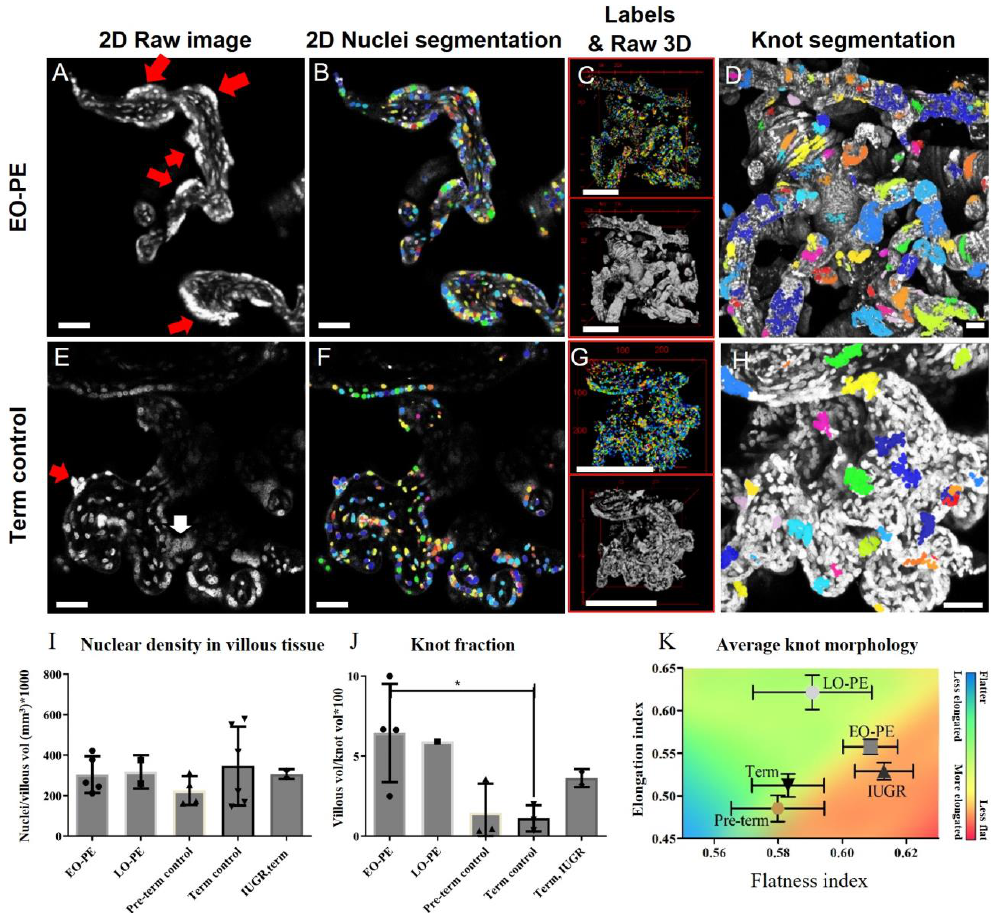
Figure 2. Nuclei segmentation with Stardist and knot segmentation with KnotMiner . ( A ) EO-PE, 2D section and ( B ) corresponding segmentation result. Red arrows point to syncytial knots. ( C ) A 3D raw image of nuclei and the corresponding 3D segmentation result. Larger images are available in Figure S5. ( D ) Segmentation of knots with KnotMiner , illustrated in the maximum intensity projec- tion of the image. ( E ) A 2D visualisation of nuclei in term control placenta. The white arrow points to a nuclear bridge (can be recognised by dense nuclei connecting two villi, but nuclei are not as bright as compared to knots). ( F ) Segmentation of nuclei in term control placenta. ( G ) The 3D seg- mentation results of nuclei in term control placenta. ( H ) Knot segmentation in term control placenta by KnotMiner . ( I ) Nuclear density (ratio of nuclei over villous volume). EO-PE n = 2 placentas (im- ages:5), LO-PE: n = 1 placenta, (images: 2), preterm: n = 2 (images 3), term control: n = 2 (images 3), IUGR: n = 1 (images:2). ( J ) Knot fraction (percentage of total knot volume over villous volume). ( K ) average knot morphology described by flatness and elongation index. Flatness index was not sig- nificantly different for the presented clinical cases. Samples in (J) and (K); EO-PE: n = 1 placenta (images:4), LO-PE: n = 1 (images: 1), preterm: n = 2 (images: 3), term control: n = 2 (images: 3), IUGR: n = 1 (images: 2). Results are presented as means ± standard deviation. Scale bars in ( A , B , D , E , F ): 50 μm. Scales bars in ( C ), and ( G ): 200 μm , * p < 0.05.